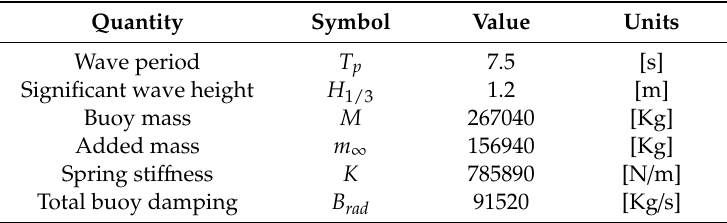
Table 2. Data of the buoy and sea state.